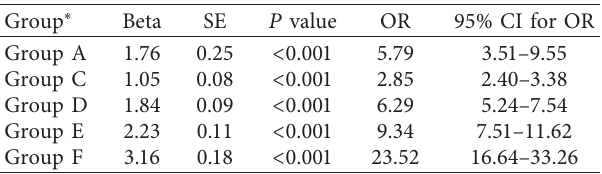
Table 3: Multivariate logistic regression analysis to include mean plasma glucose for prediction of death